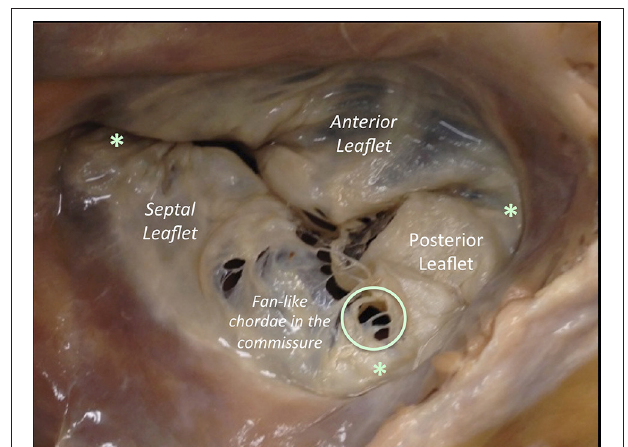
FIGURE 3 | The anterior leaflet of the TV is larger than the posterior, which is larger than the septal leaflet. The anterior leaflet is primarily attached to the right ventricular outflow tract, the posterior to the muscular wall of the right ventricle and the septal one to the septum. The anterior has a semicircular shape and likewise the MV, it is divided into an atrial zone, regular, and thin, and into a distal zone, the zone of coaptation, slightly irregular and thicker than the proximal one. In comparison to the MV, few chordae are attached to the ventricular side of the leaflet. The posterior leaflet, slightly smaller than the anterior is divided in the same proximal and coaptation zones. The septal leaflet is the smaller and less mobile, and roughly semicircular and likewise the other two leaflets, it has a proximal and a coapting zone. The commissures of the TV are three and separate the three leaflets (red asterisk). They are small semilunar leaflets, attaching on the annulus and with a free edge attaching characteristics fan-like chordae. There is one variable to take into account: in comparison to the left, the septal attachment of the TV is at a more apical level than the septal attachment of the MV. As a result, a portion of the membranous interventricular septum separates the LV from the right atrium (this anatomical feature explains left ventricular to right atrial shunts diagnosed in congenital malformations). This image has been adapted from Taramasso et al.